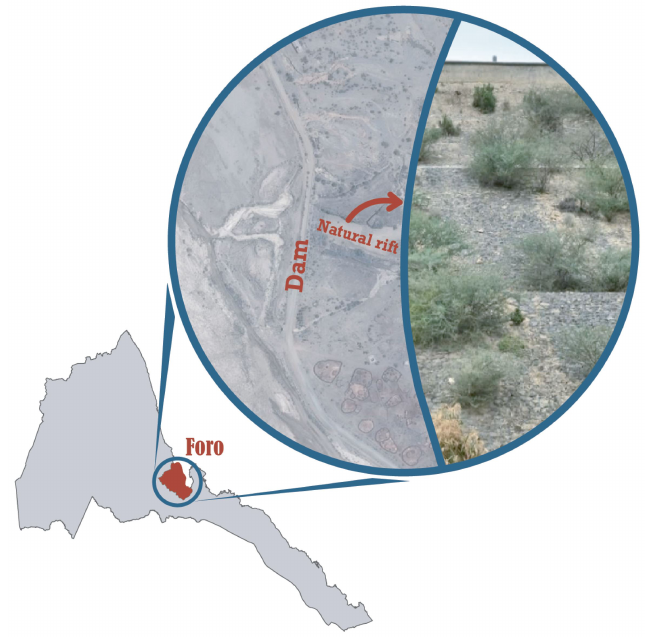
Figure 1. Study area: satellite view of the dam at Foro and the natural rift.